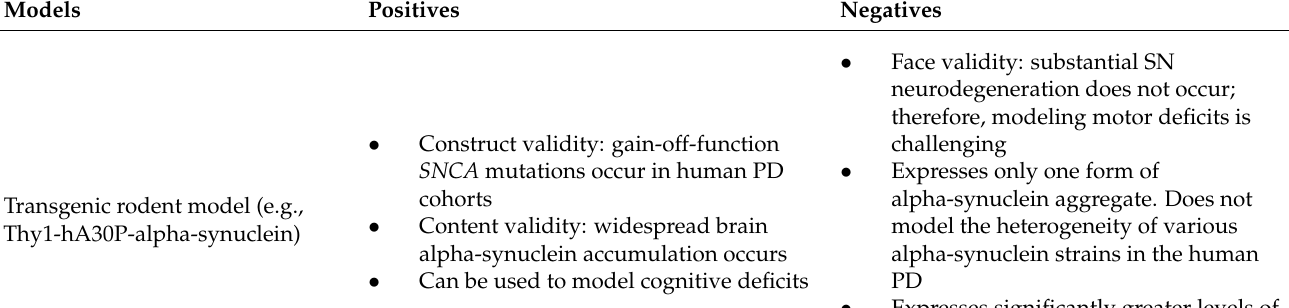
Table 2. Advantages and disadvantages of alpha-synuclein aggregation animal models.